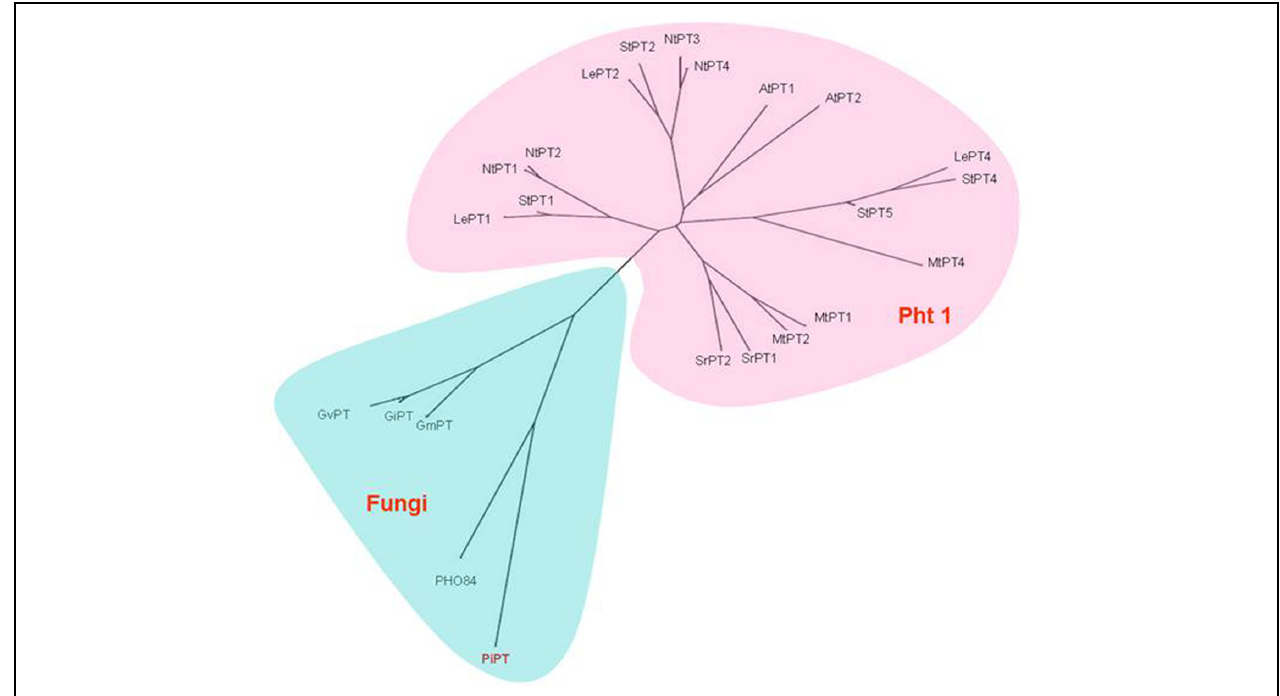
FIGURE 5 | Unrooted phylogenetic relationship of PiPT to other high affinity Pi transporters from plants and fungi (Yadav et al.,